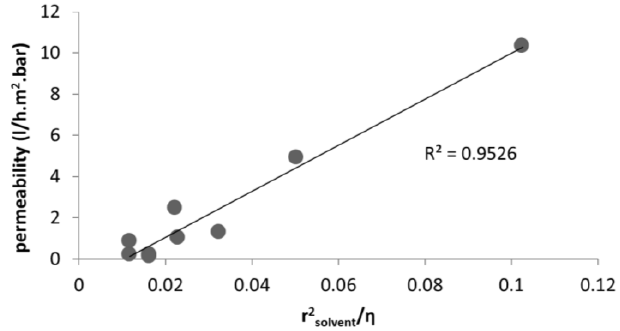
Figure 3. Solvent permeability versus 𝑟 solvent2 /𝜂 studied by [46]. Table 3. Solvent permeability through the ceramic Si–Zr membrane reported by [40].